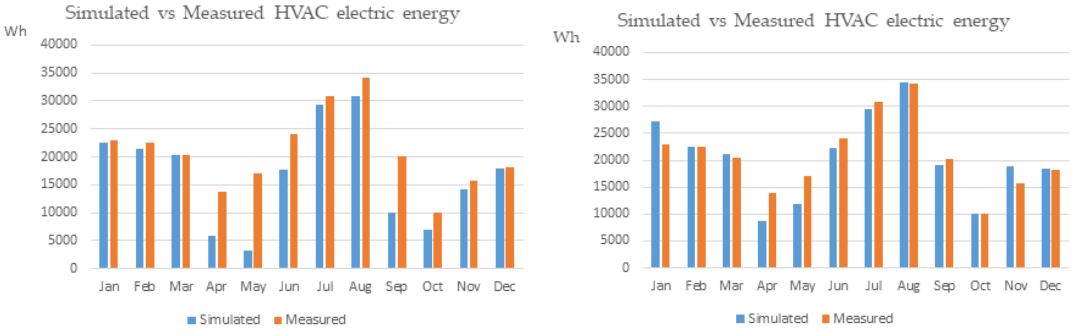
Figure 6. Measured total HVAC electrical energy consumption for the year 2018 versus: ( a ) initial model (baseline) ( left plot ) and ( b ) parameterized model (optimized) ( right plot ).